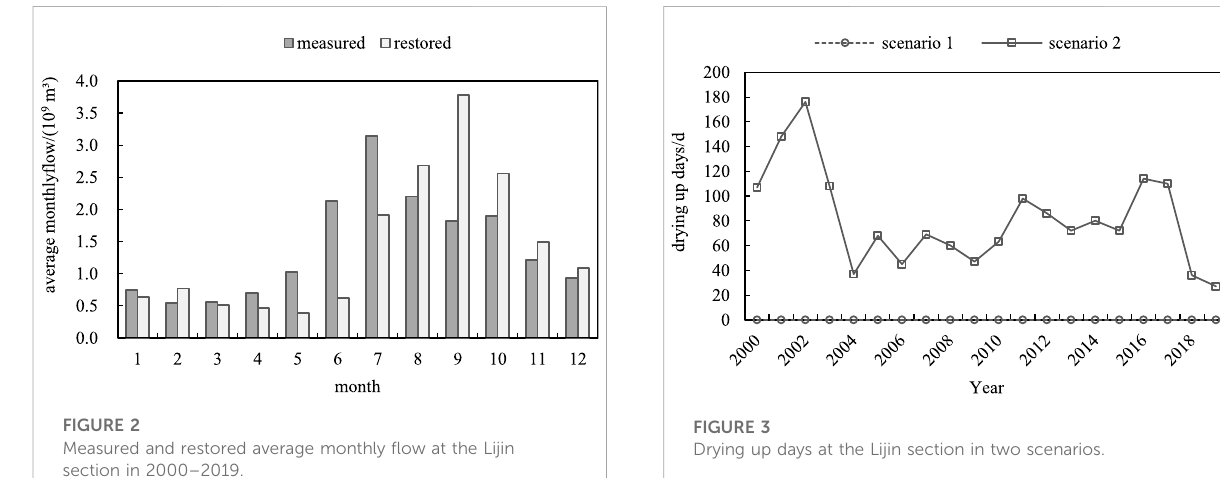
FIGURE 2 Measured and restored average monthly fl ow at the Lijin section in 2000 – 2019.